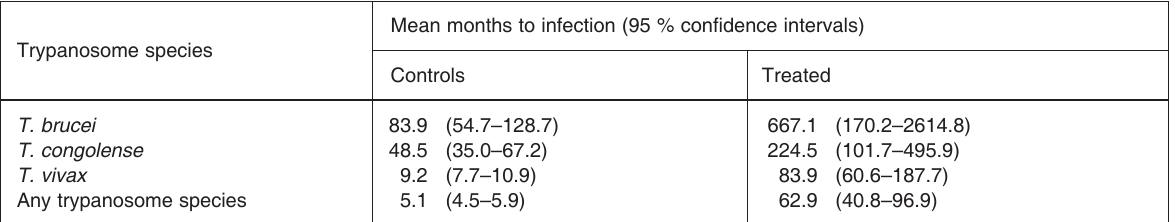
TABLE 1 The mean time, in months, to infection (with 95 % confidence intervals) for control and treated cattle (ISMM and DIM groups combined) in under a suppressed tsetse population in southeast Uganda estimated from the survival analyses Mean months to infection (95 % confidence intervals) Trypanosome species